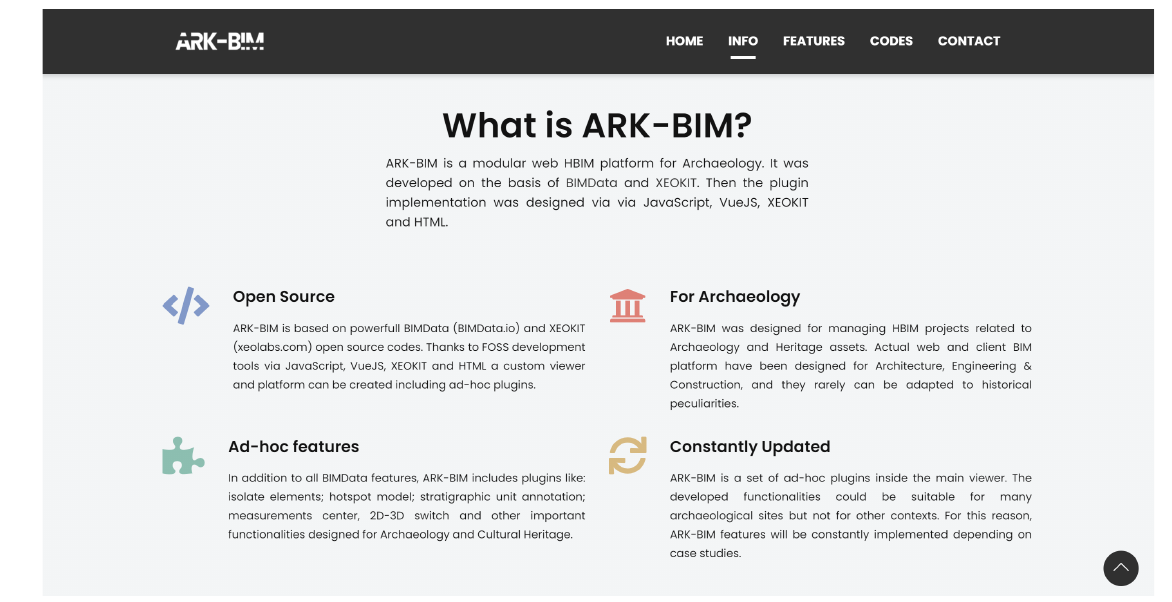
Figure 20. ARK-BIM website. Homepage and platform information with features and main purposes.